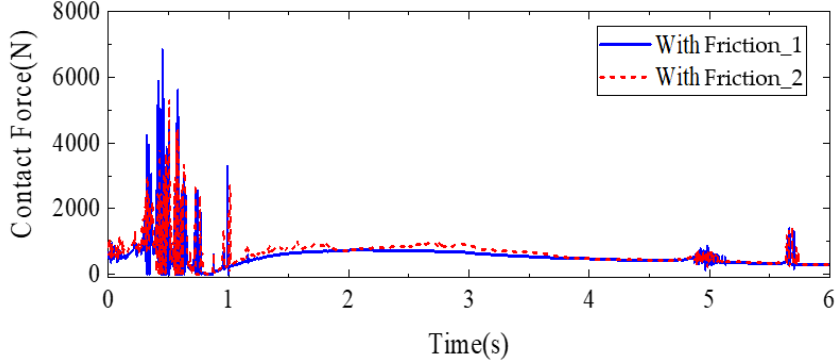
Figure 13. Change curve of joint contact force when considering friction.